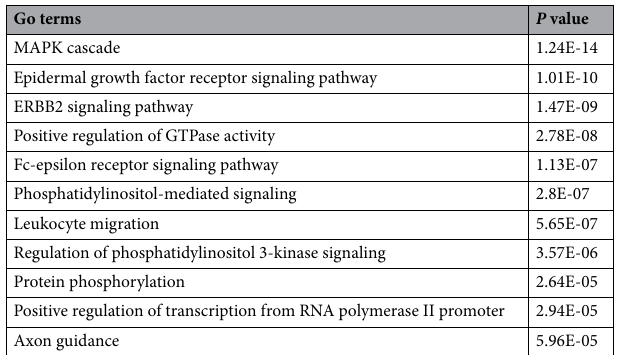
Table 6. GO analysis of PPI.